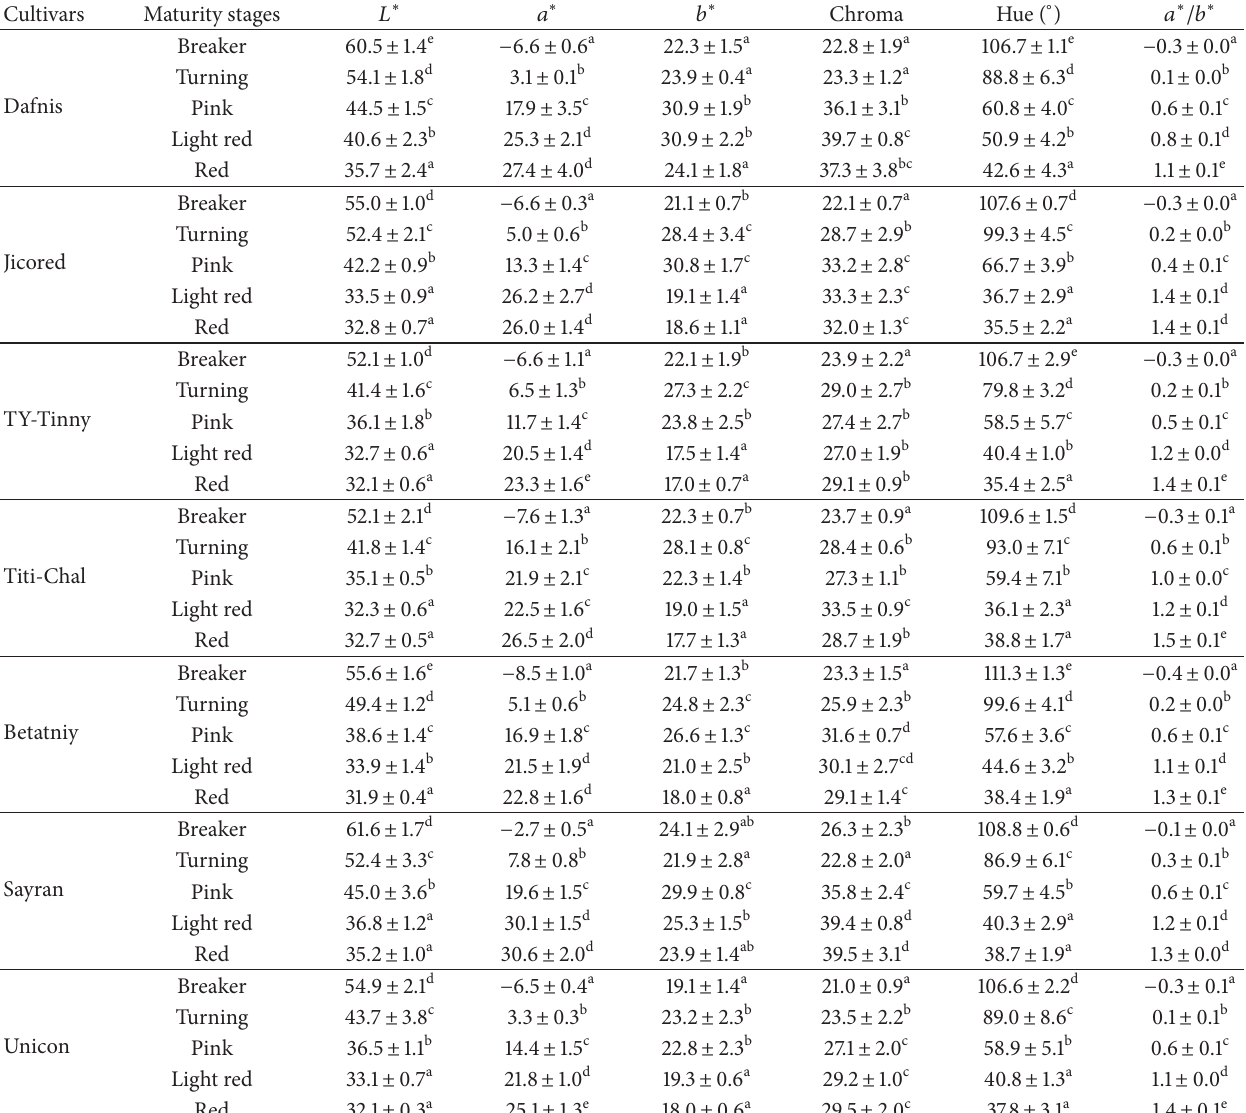
Table 4: Color attributes in tomato fruits at different ripening